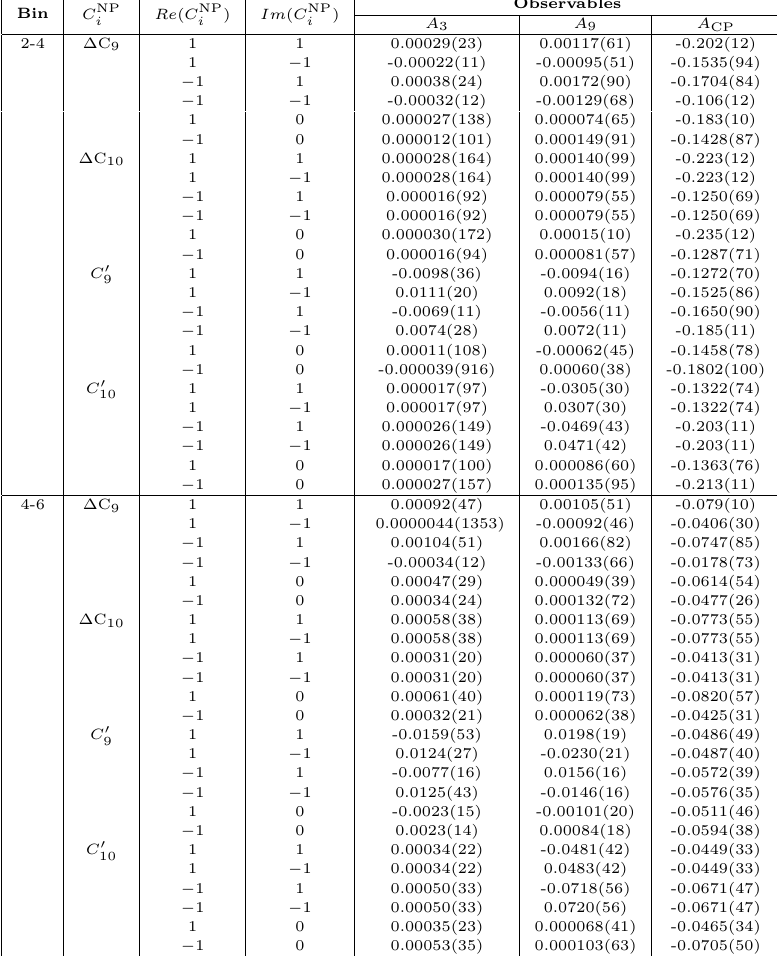
Table 23 . The dependence of the asymmetric observables corresponding to B ± → ρ ± ll on the real and imaginary parts of the NP WC’s ∆ C few benchmark values of the real and imaginary parts of the corresponding